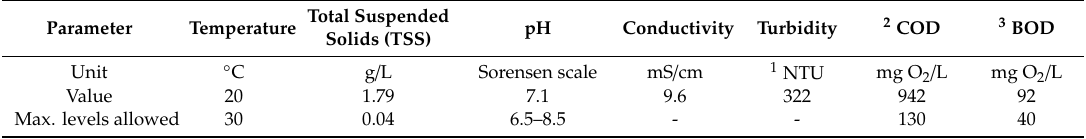
Table 1. Physicochemical characteristics of TAMEG-Rouiba Tannery e ffl uent.